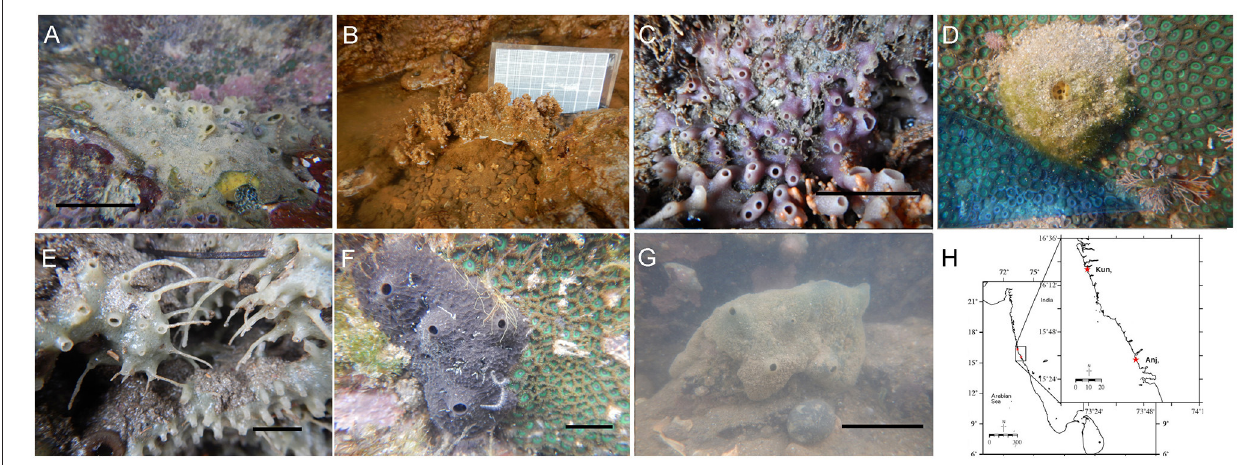
FIGURE 1 | The study species (A) Amorphinopsis foetida, (B) Biemna fortis, (C) Calyspongia sp., (D) Cinachyrella cf. cavernosa, (E) Haliclona sp., (F) Ircinia fusca, (G) Suberites carnosus, (H) . The study area showing the location of Anjuna (Anj) and Kunkeshwar (Kun). [Scale (A) = 5cm, (C) = 3cm, (E) = 2cm, (F) = 5cm, (G) =